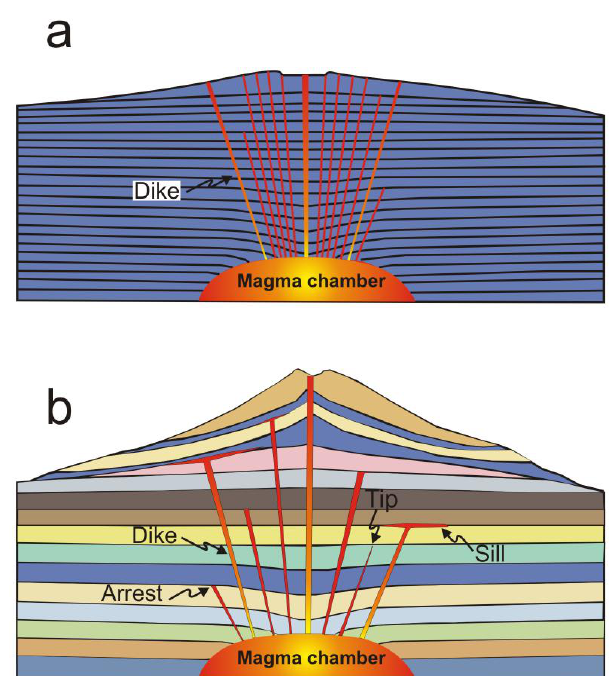
Fig. 10. (a) A basaltic edifice is composed primarily of mechani- cally similar layers so that, once initiated, landslide faults (or slip surfaces or failure planes), ring faults, and dikes have a compara- tively high probability of reaching the surface, as indicated here by the many feeder dikes. (b) A stratovolcano is composed of mechan- ically dissimilar layers so that faults and dikes have comparatively low probability of reaching the surface, as indicated here by the many arrested and deflected (into sills)